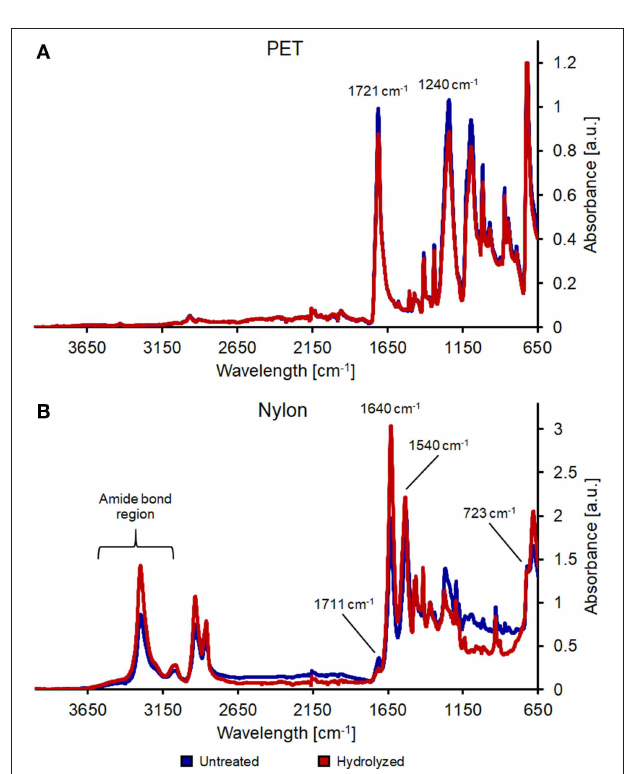
FIGURE 2 | FT-IR analysis of untreated (blue line) and enzymatically hydrolyzed (red line) PET (A) and nylon-6 (B) .